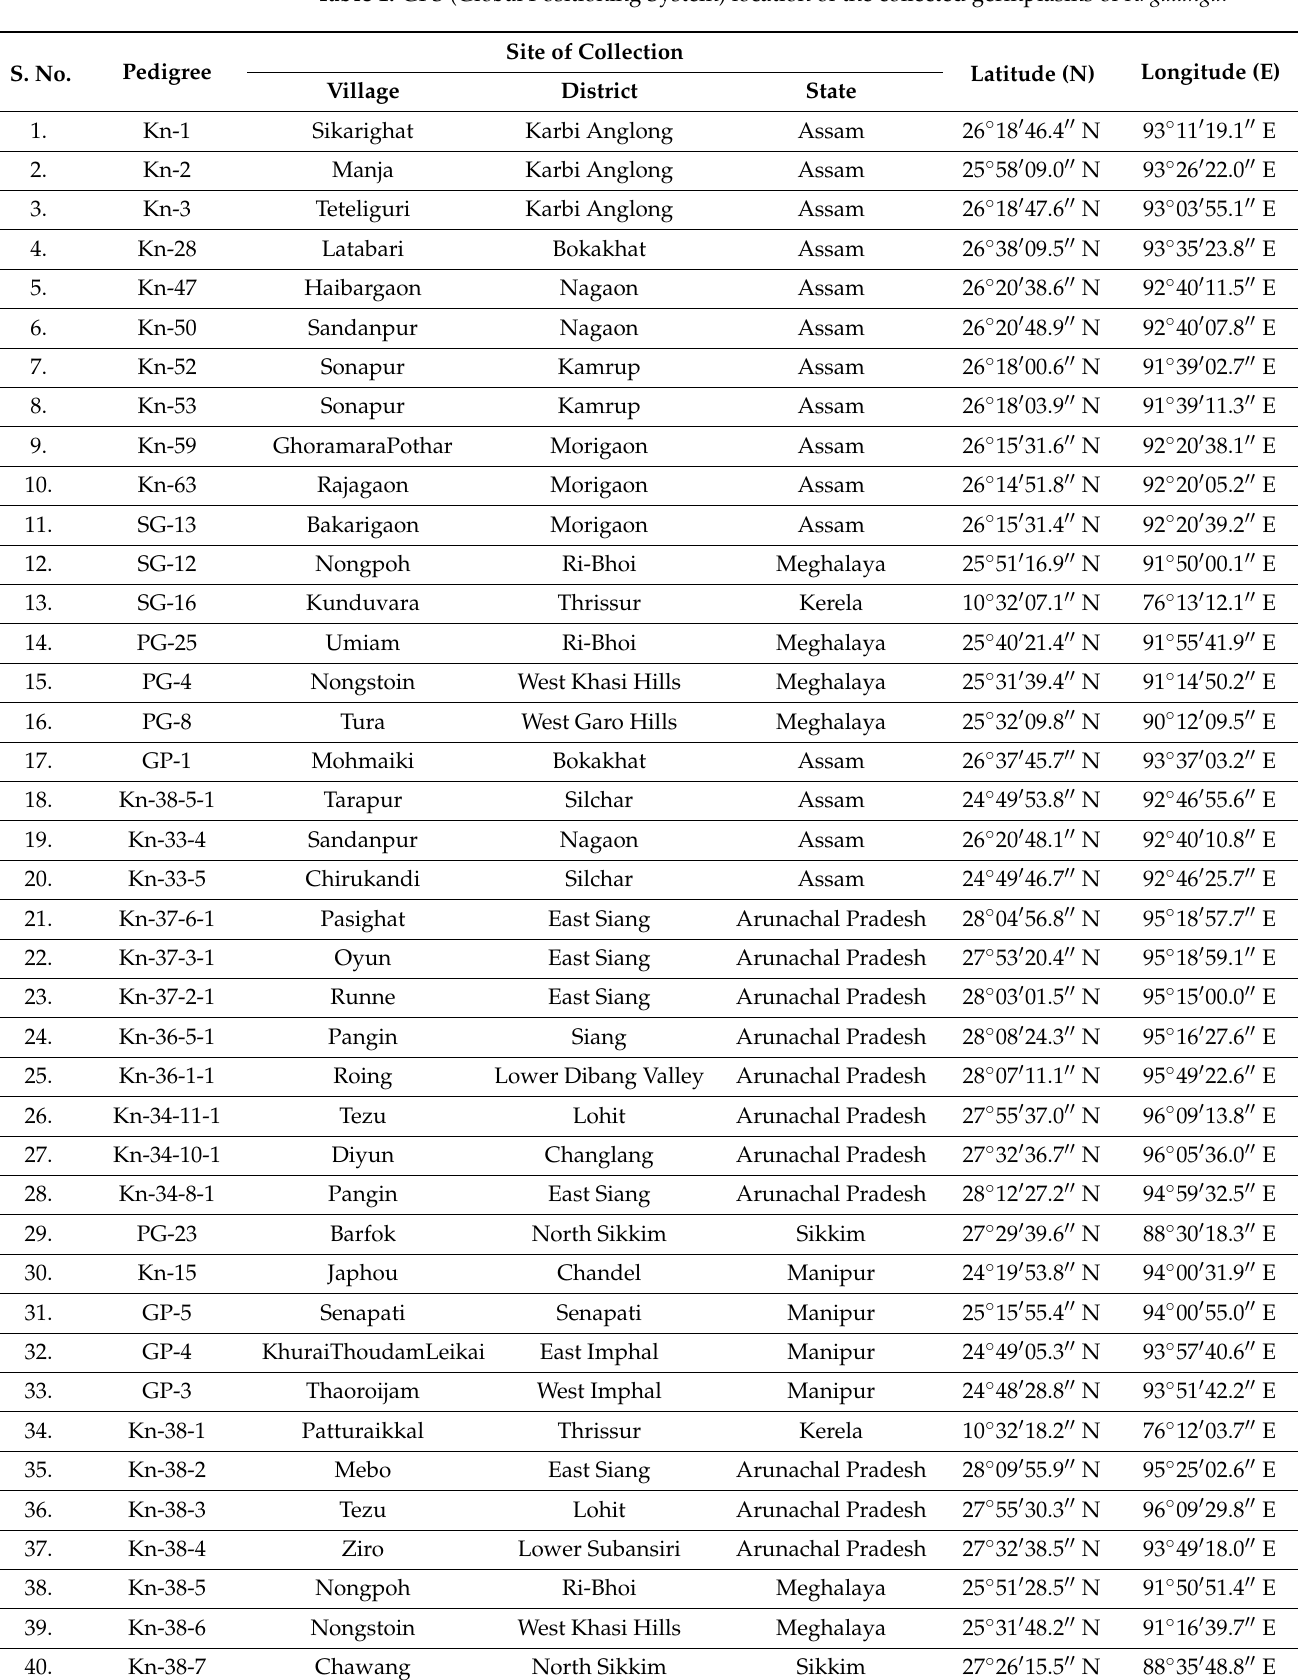
Table 1. GPS (Global Positioning System) location of the collected germplasms of K. galanga .